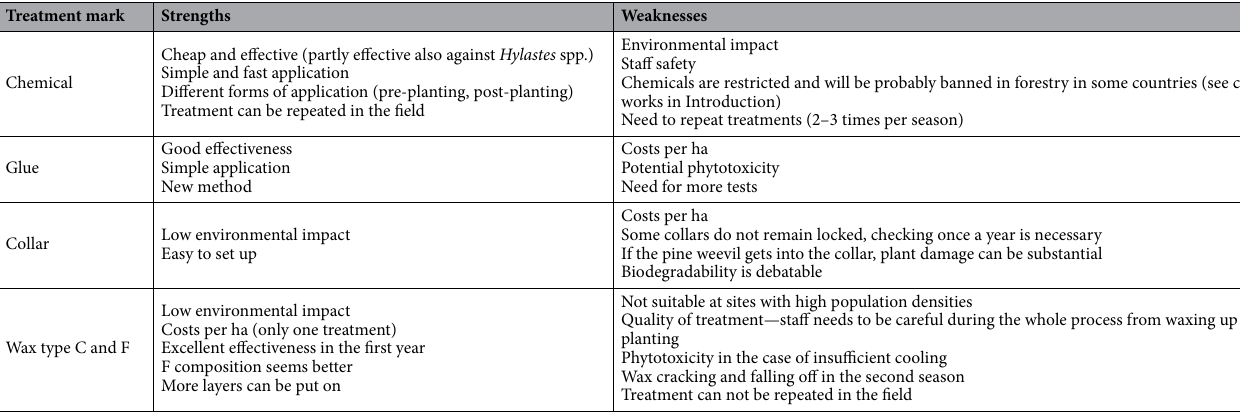
Table 8. Strengths and weaknesses of the treatments used to reduce H. abietis damage to seedlings in this